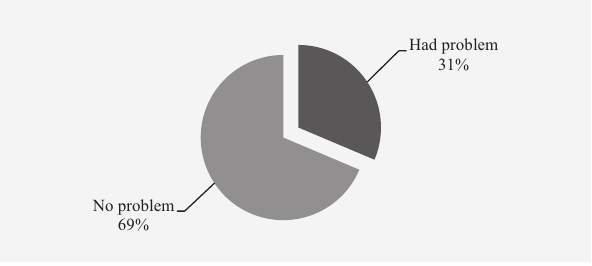
Figure 2. Percentage distribution of neonates with reported